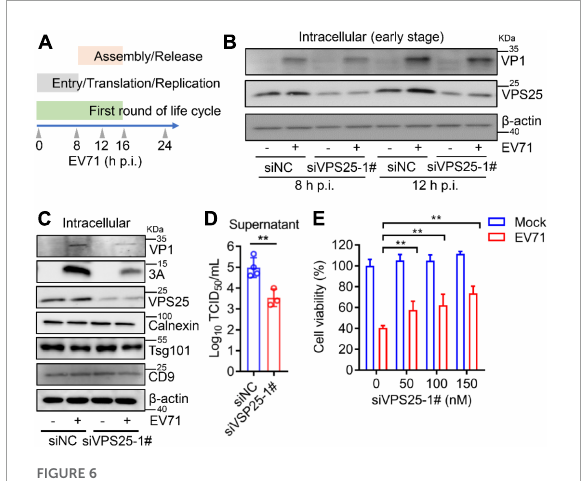
FIGURE6 Vacuolar protein sorting 25 (VPS25) mediates EV71-induced exosome to facilitate viral replication. (A) Schematic of kinetic time points in the EV71 life cycle. (B–D) RD cells were transfected with 100 nM siNC or siVPS25-1# for 24 h and then infected with EV71 (MOI = 0.5). At 8 and 12 h p.i., the cell lysates were analyzed by Western blot (B) . At 24 h p.i., the cell lysates were analyzed by Western blot (C) and the progeny virus titer was measured by TCID50 assay (D) . (E) RD cells were transfected with different doses of siNC or siVPS25-1# (0, 50, 100, and 150 nM) for 24 h and then infected with EV71 (MOI = 0.5) for another 24 h. Cell viability was measured using the CCK8 assay. Graph shows as mean ± SD. ** P < 0.01.